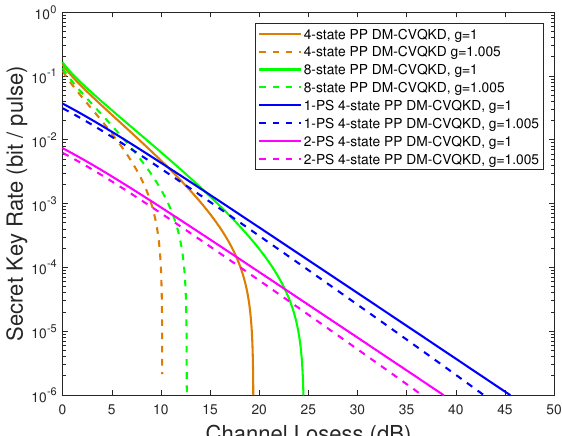
Figure 4. The secret key rate as a function of channel losses. The solid line corresponds to the case that g = 1 and the dash line corresponds to g = 1.005. The modulation variance V M = 0.5, the channel excess noise ε = 0.01, and the reconciliation efficiency β =